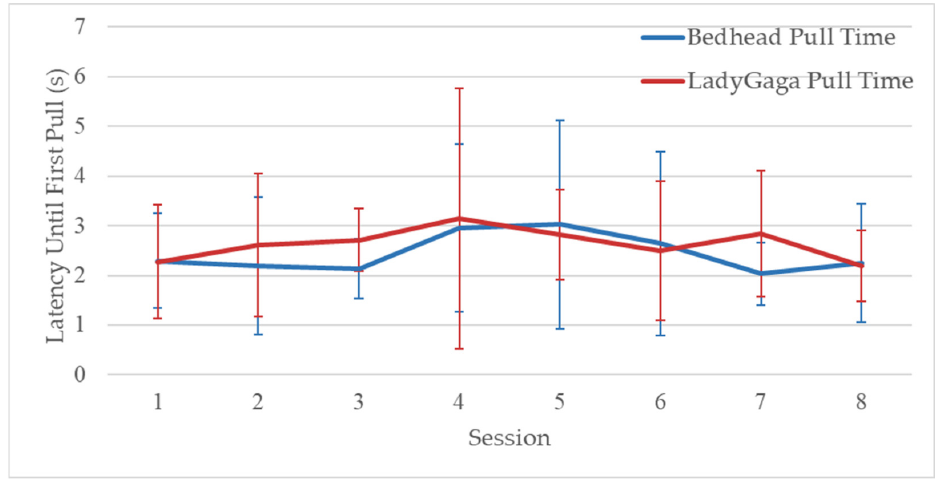
Figure 5. Average latency until first pull for each porcupine across sessions in Phase 2. Error bars depict standard deviations.